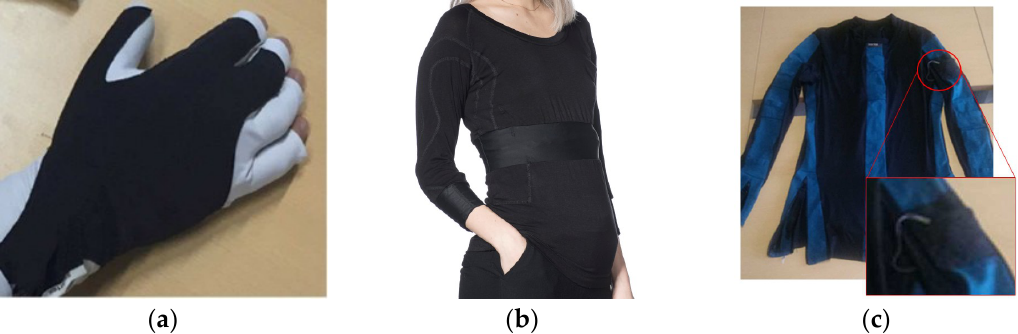
Figure 2. Different textile pieces integrating electronics for movement quantification in different areas of the body: ( a ) Glove for recognition of eight fundamental hand positions for Stroke patients [17]; ( b ) T-shirt to quantify symptoms of Parkinson’s Disease (PD), Epilepsy and Stroke patients [11]. ( c ) T-shirt to assess Stroke patients arm movement during daily activities [17].